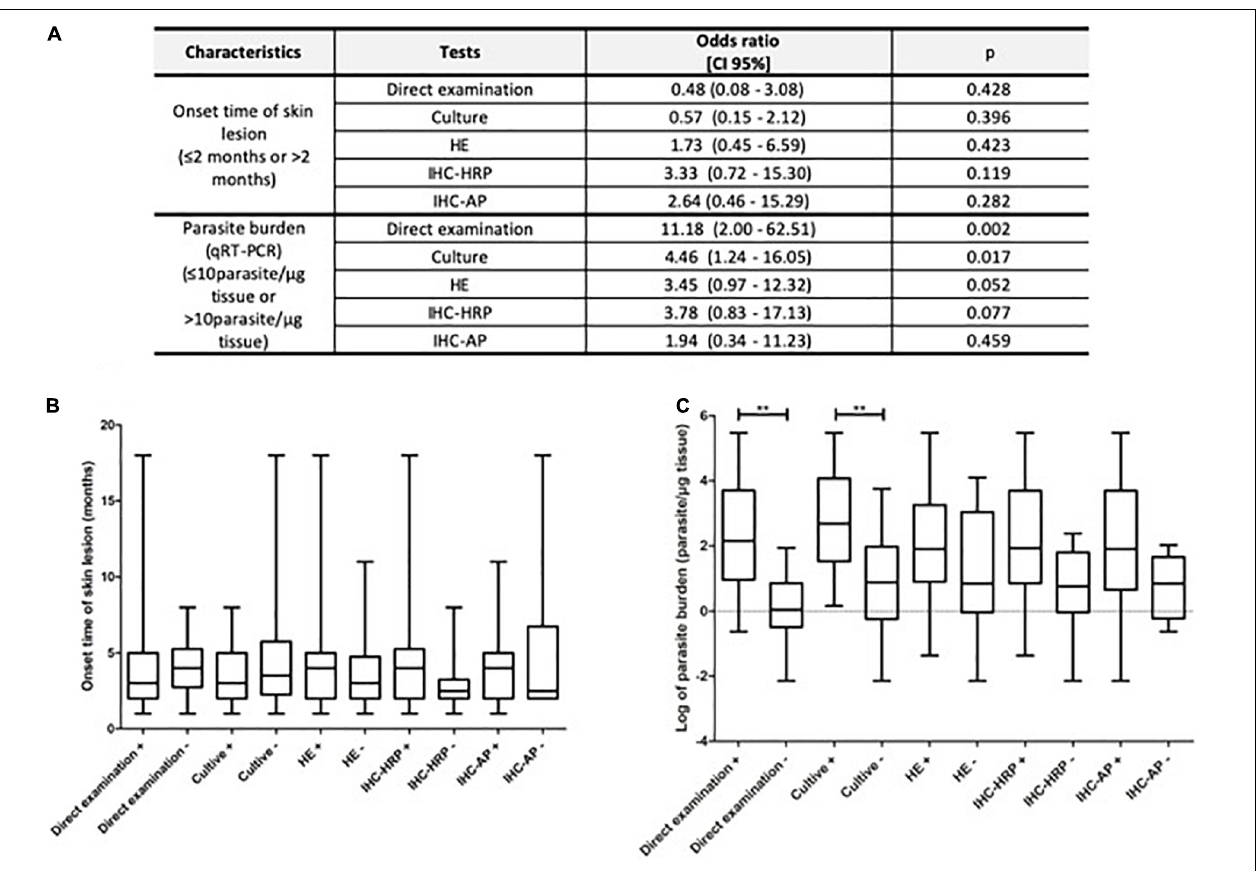
FIGURE 4 | Relationship between test positivity and skin lesion onset time and parasite burden. Multivariate analyses: (A) graphic demonstration of skin lesion onset time (B) and parasite burden (C) according to the results of the diagnostic tests (** P ≤